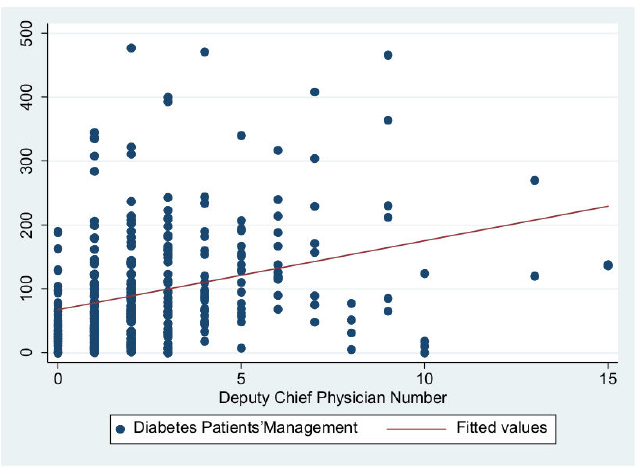
Figure 5. Scatter diagram of diabetes patient management and total number of deputy chief